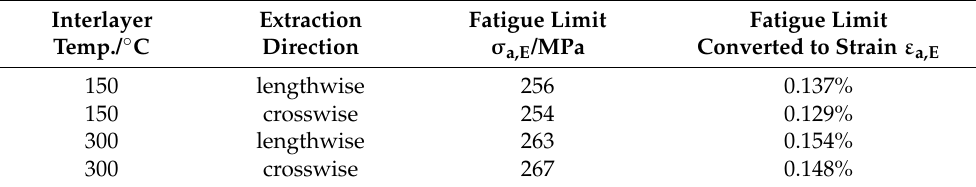
Figure 22. Strain–life curves (logarithmic scale) from the strain-controlled tests, including the fatigue limits from the stress-controlled tests [189]. Table 2. Fatigue limits determined by staircase tests at 5 × 10 6 cycles with a probability of failure Pf = 50%